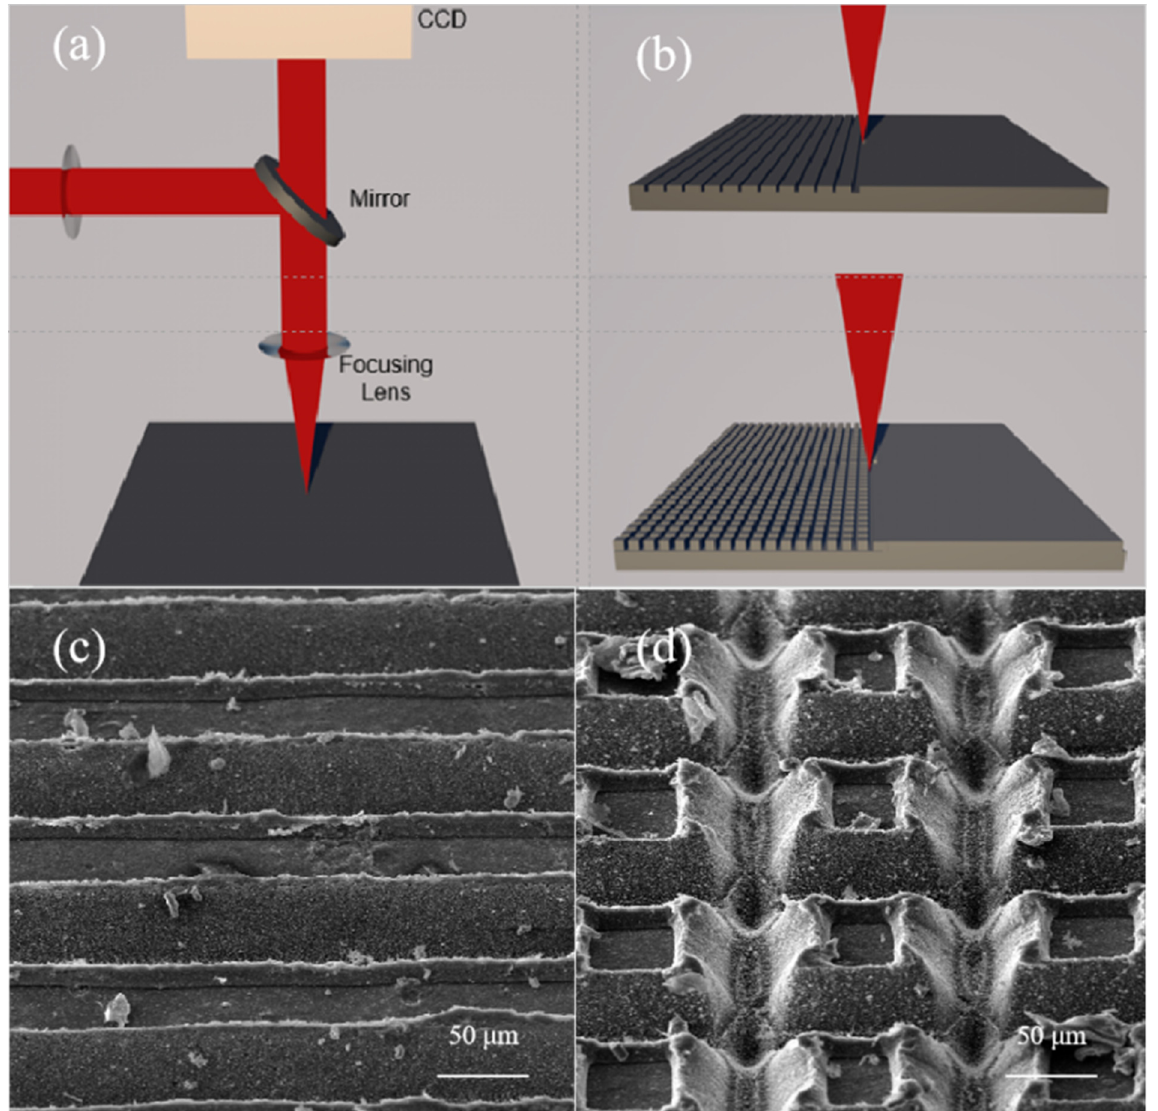
Figure 1. ( a ) Schematic of the laser machining system, ( b ) two types of scanning mode, ( c ) a 45° field of view SEM figure of grooves with 80 μ m spacing, and ( d ) a 45° field of view SEM figure of grids with 100 × 100 μ m 2 spacing.